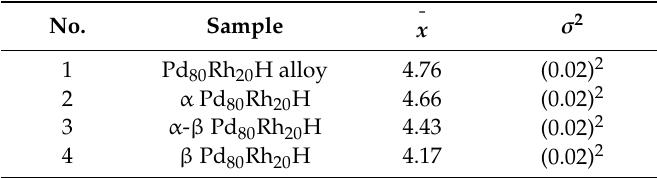
Table 2. Values of parameters from the Gaussian distribution curves of work function for the Pd 80 Rh 20 alloy and α , α - β , β Pd 80 Rh 20